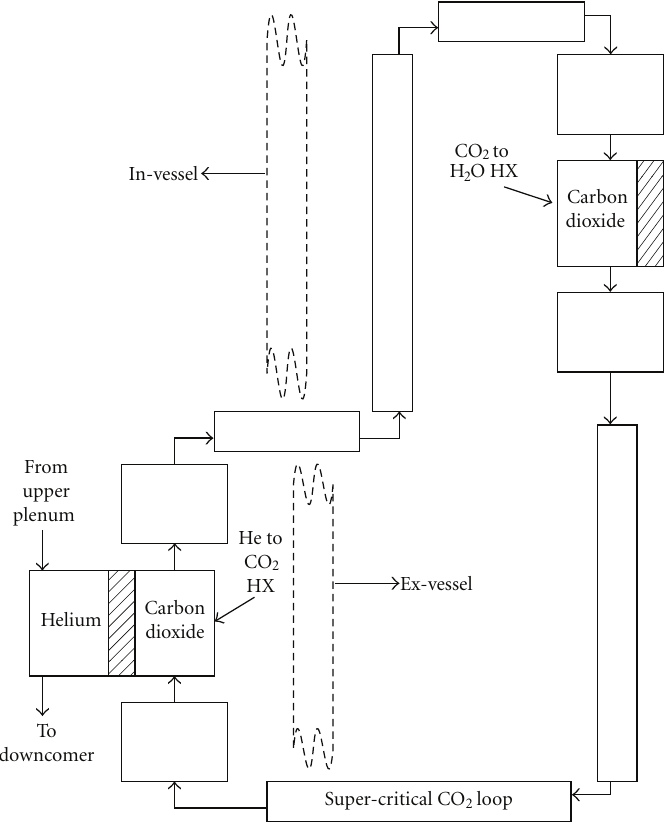
Figure 2: RELAP5 model of emergency heat exchanger system.